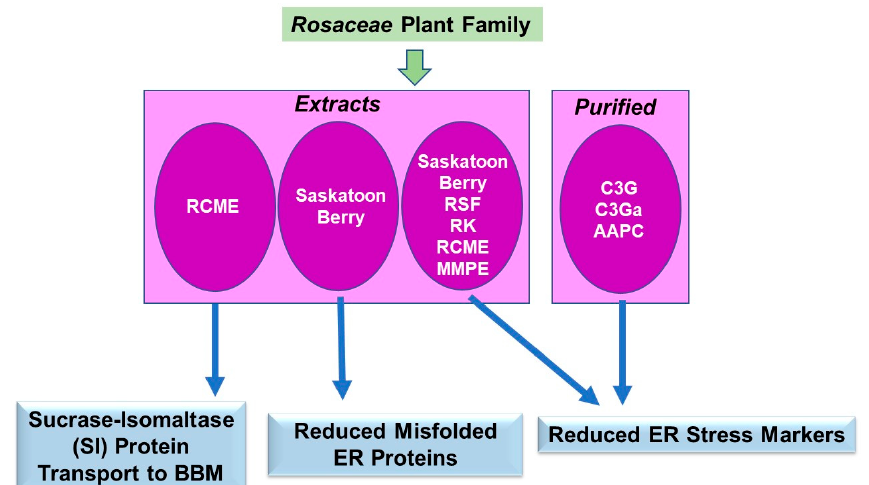
Figure 8. A schematic summary of the effects of metabolites from Rosaceae on protein trafficking dynamics.